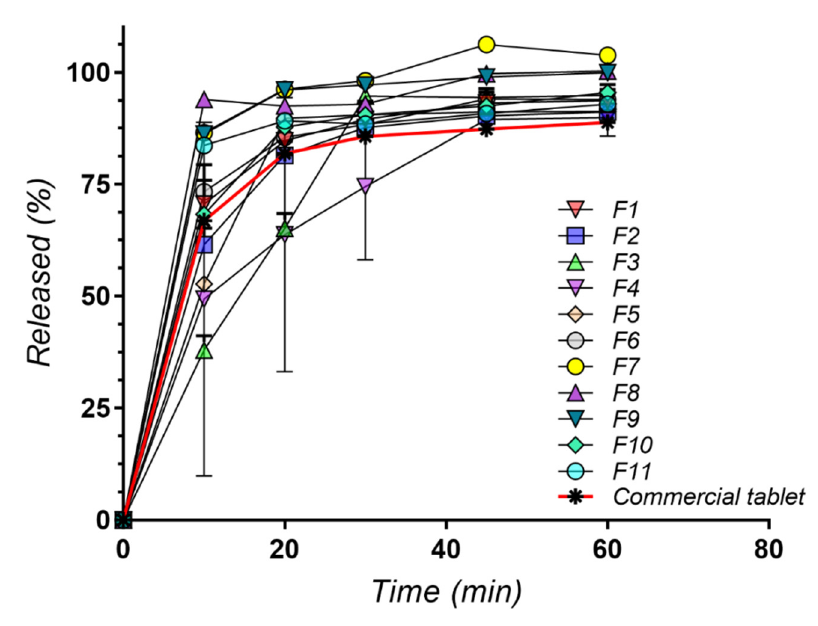
Figure 9. Dissolution profiles for all series of tablets. Comparison between formulation F1–F6 (mixtures of amiodarone with PEG and poloxamer) and F7–F11 formulations (mixtures of Soluplus with polymers) showed an increase in the initial dissolution rate in the first 10 min for the formulations with Solup ‐ lus ® (Figure 10a,b). This is a good indicator of formulation performance taking in consid ‐ eration that in oral immediate ‐ release tablets formulation the first 15 min plays an im ‐